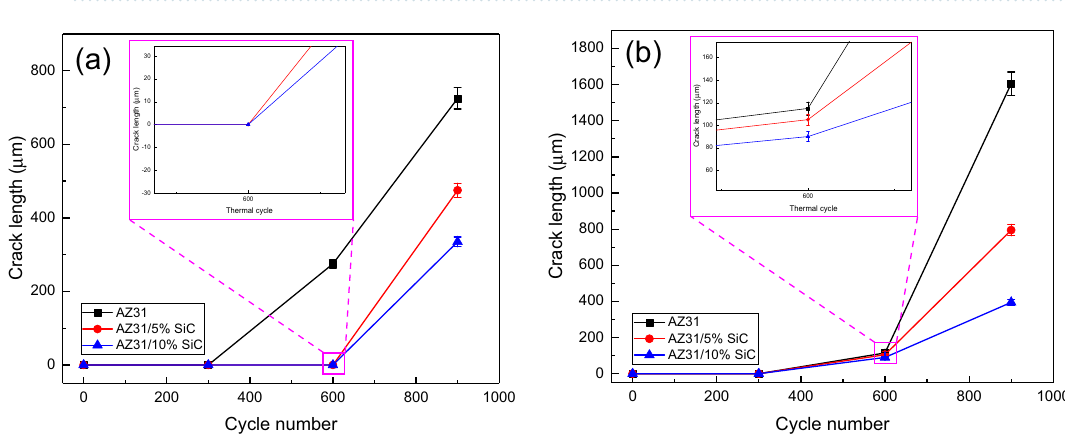
Figure 10. Crack length of the as-cast samples after thermal cycle at: ( a ) 150 °C, and ( b ) 350 urement of the CLs under thermal cycles at 350 °C are shown in Figs. 15b and 16, respectively. According to the Fig. 16, it is clear that after 600 cycles, the unreinforced AZ31 alloy cracks nucleated and grew to a length of 45 μm, and by increasing the number of cycles to 900, the crack grew and reached a length of 1035 μm, showing an increase of 2200%. After 300 cycles, no crack was observed at the notch tip for AZ31/5%SiC and AZ31/10%SiC, and after 600 cycles, 85 μm and 65 μm long cracks were formed, respectively. Furthermore, after 900 cycles, 365 and 115 μm long cracks were observed for AZ31/5%SiC and AZ31/10%SiC samples, 65% and 88% less than unreinforced alloy cracks with the same number of cycles, respectively. During the entire process, cracks may meander. This is because of particles that are likely to affect the direction of the crack tip, and then cracks move forward along less strong positions, namely voids and weak interfaces. Noteworthy is the fact that bonding strength concerning the interface of particle and matrix may impact the stress intensity factor at the crack tip. In addition, when the main crack propagated, a distinct pattern of crack appeared at the crack front. It is believed that detached particles or void defects are responsible for this pattern’s occurrence; in fact, it seems they merge into the main crack, thus accelerating crack growth. Figure 16 displays the front of the main crack where sub-cracks were configurated and combined after several cycles. Defects and